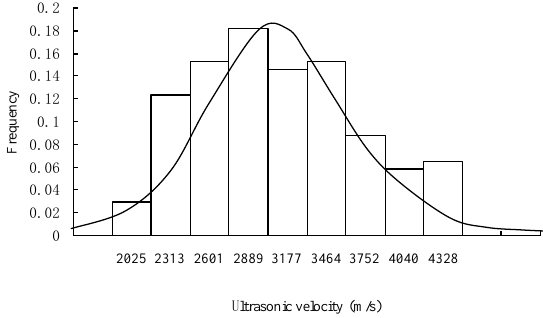
Figure 9. Histogram on ultrasonic velocity of RFC.